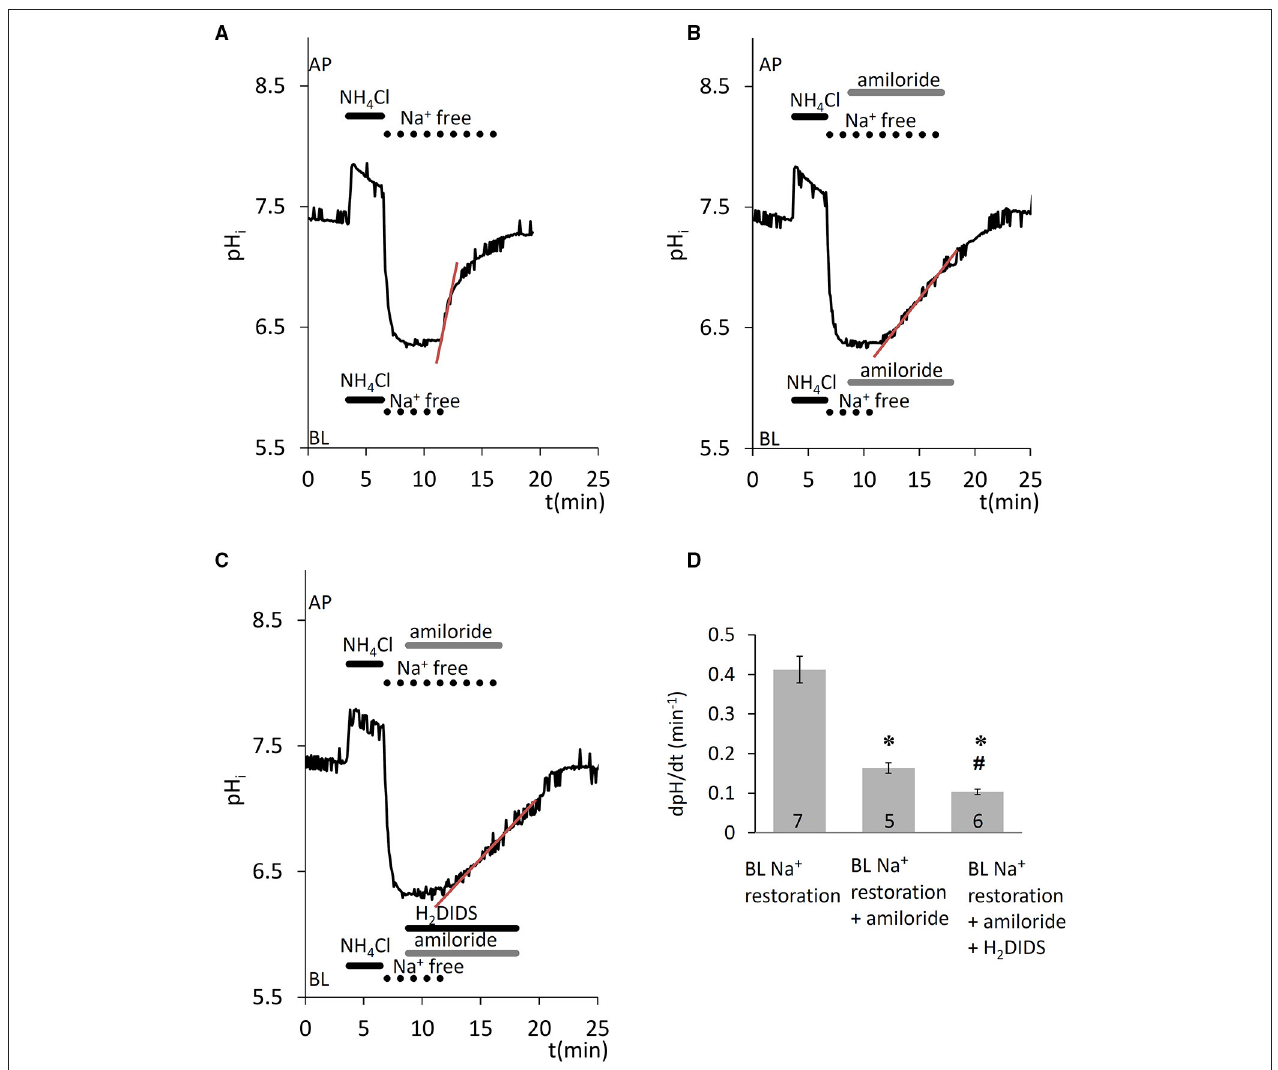
FIGURE 2 | Recovery of pH i in HAT-7 cells exposed to an acid load in the presence of HCO − 3 /CO 2 . HAT-7 cells grown on Transwell membranes were exposed bilaterally to 20mM NH 4 Cl followed by bilateral substitution of Na + with NMDG + . (A) Recovery of pHi following basolateral restoration of extracellular Na + . (B) Inhibition of pH i recovery following restoration of Na + in the presence of basolateral (BL) amiloride (300 µ M). (C) As for panel B but with the amiloride-containing BL solution supplemented with H 2 DIDS (500 µ M) in order to block the NBCe1 cotransporter. (D) Mean dpH/dt ± SEM values calculated from the initial rates of increase in pH i following restoration of Na + in the presence and absence of the inhibitors ( n = 5–7). * p < 0.05 compared to control, # p < 0.05 compared to amiloride